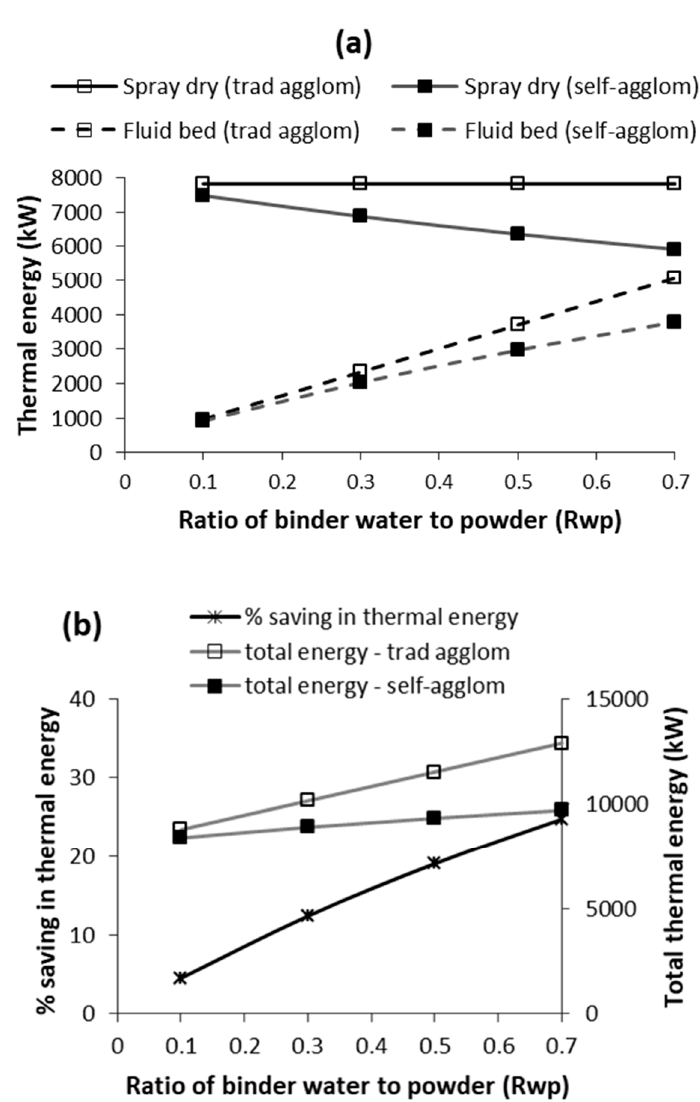
Figure 4. E ff ect of ratio of binder water to powder ( R wp ) on thermal energy requirements of traditional agglomeration and self-agglomeration: ( a ) spray drying and fluid-bed energy; and ( b ) total energy and % saving in energy due to self-agglomeration as compared to traditional agglomeration. [ X c = 30%; binder solids concentration ( X b ) = 30% for self-agglomeration].